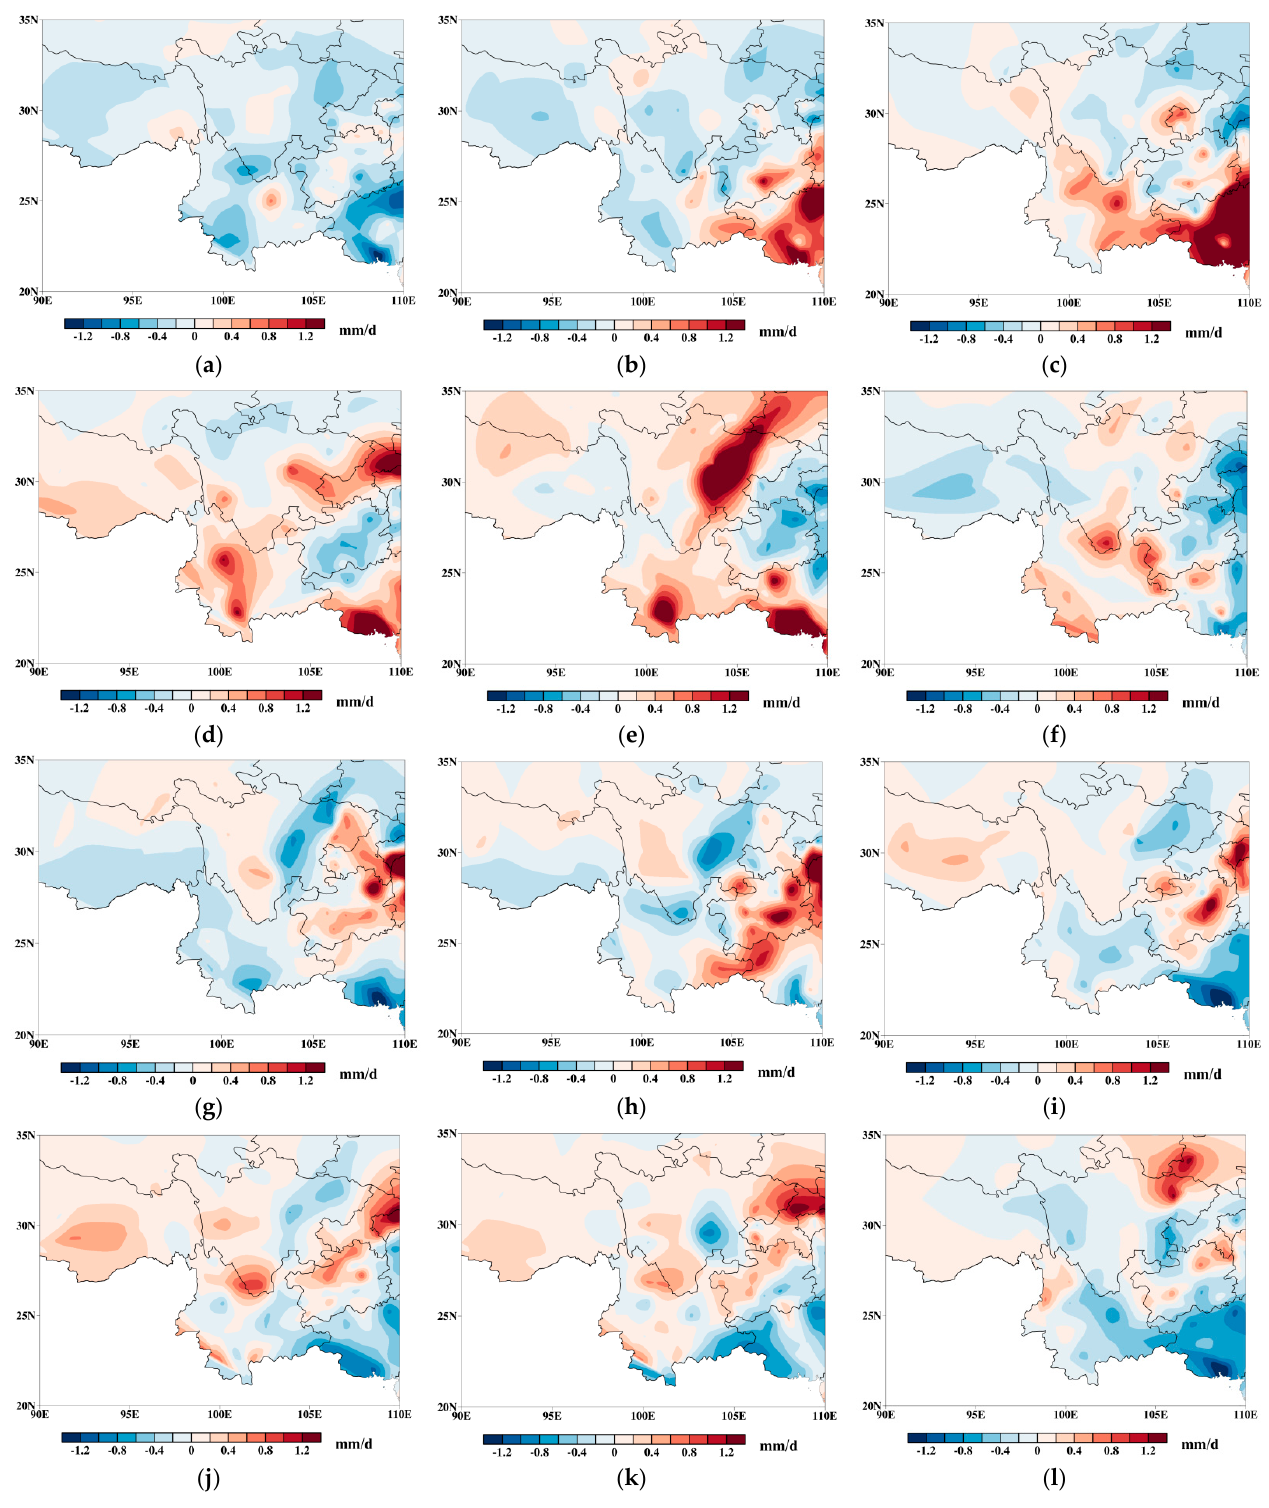
Figure 13. Abnormal precipitation in southwest China for 30–60 days ISO of the EASM in 1998. (Unit: mm·d − 1 ; ( a – f ) means the phases 1–6 of the first cycle; ( g – l ) means the phases 1–6 of the second cycle). In phase 1 of the second cycle, precipitation in southwest China was relatively less, and maximum areas of precipitation were mainly located in Chongqing and Guizhou, and there were obvious negative precipitation anomaly regions in southern Guangxi, central Sichuan, southern Yunnan, etc. In phase 2, maximum areas of precipitation